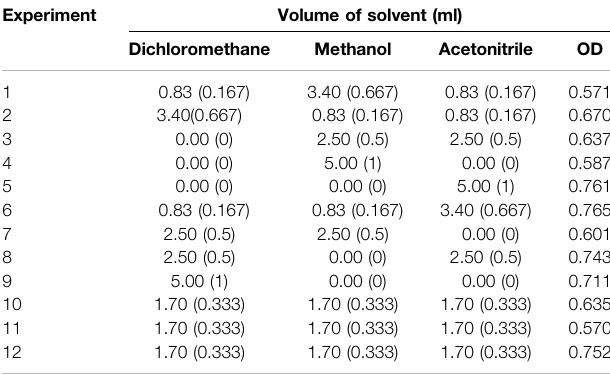
TABLE 1 | Experimental conditions of the mixture design performed for the extraction solvent optimization, and the responses in terms of overall desirability (OD). The coded values are shown within parentheses.